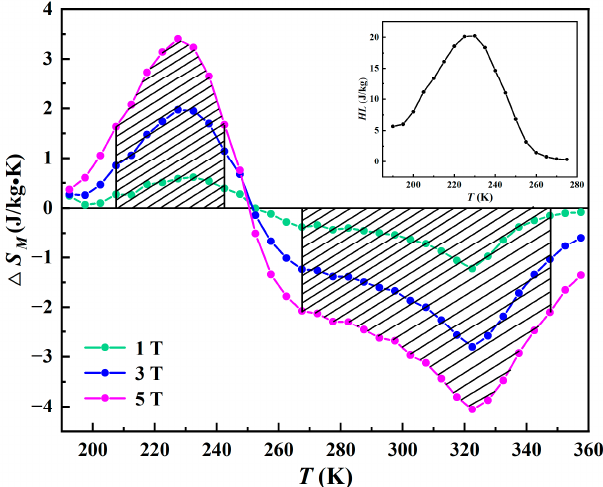
Figure 7. Temperature dependence of magnetic entropy change under several magnetic fields. Inset: HL as a function of temperature for a magnetic field change of 5 T.